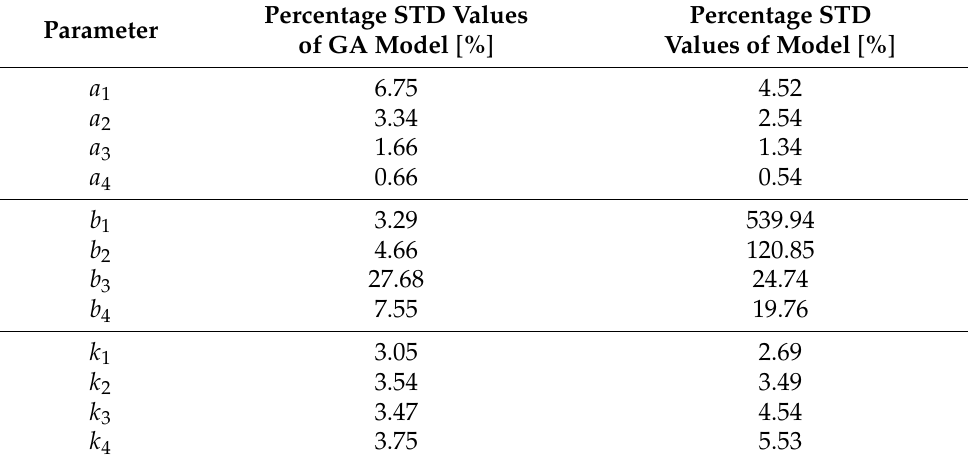
Table 6. Percentage STD values in relation to the model parameter